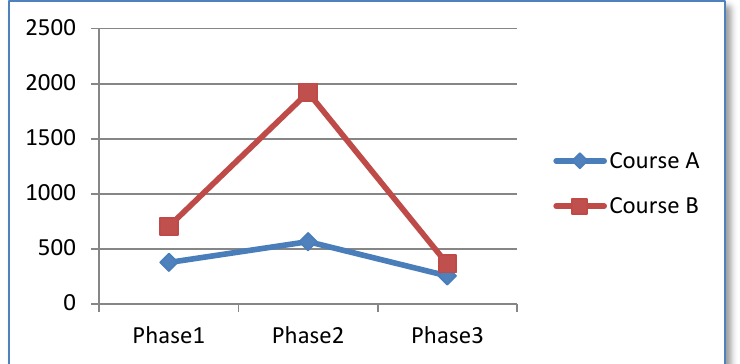
Figure 8 . Average time-on-task (in minutes) for each phase for the two courses.